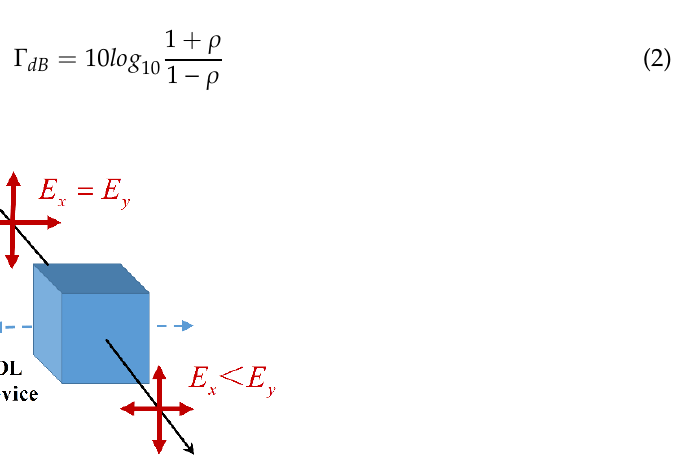
Figure 1. Schematic of polarization-dependent loss (PDL).